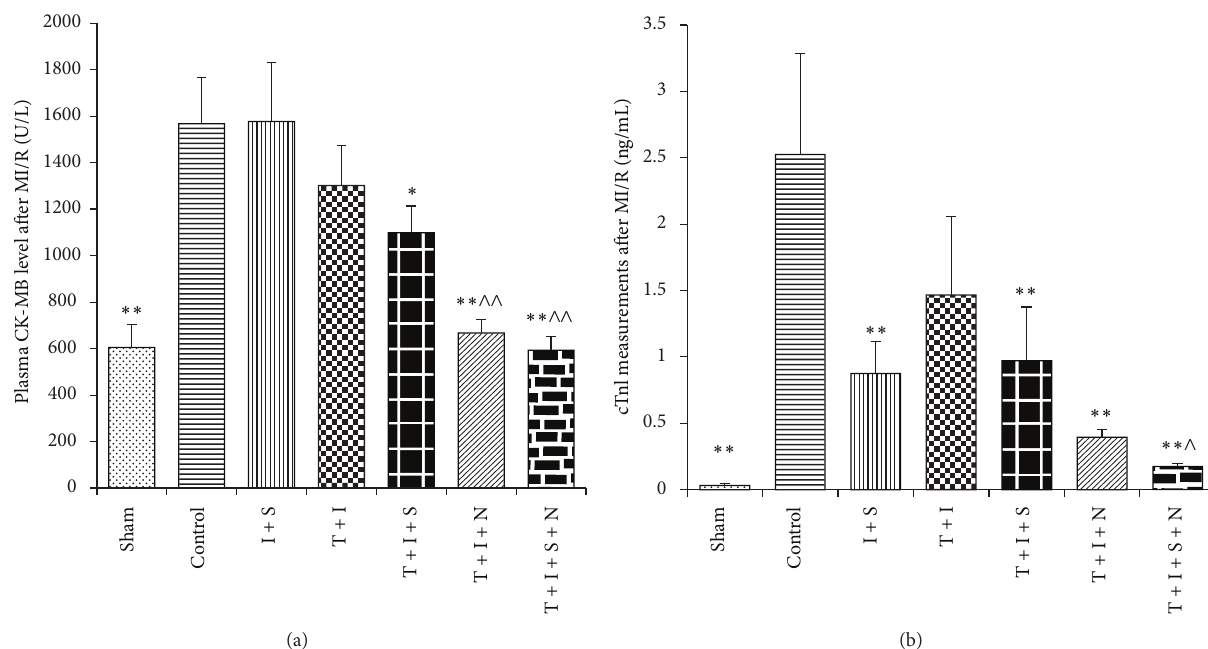
Figure 2: Plasma CK-MB (a) and cTnI (b) measurements after MIR. Plasma was, respectively, separated from blood samples immediately collected after reperfusion. Data was expressed as mean ± SEM ( 𝑛 = 12 per group), I, T, S, and N, respectively, stand for ischemia-reperfusion (I), Type 1 diabetes (T), sevoflurane (S), and N-Acetylcysteine (N); control: ischemia-reperfusion untreated group. ∗ 𝑃 < 0.05 ; ∗∗ 𝑃 < 0.01 compared with control group; ∧ 𝑃 < 0.05 and ∧∧ 𝑃 < 0.01 compared with T + I